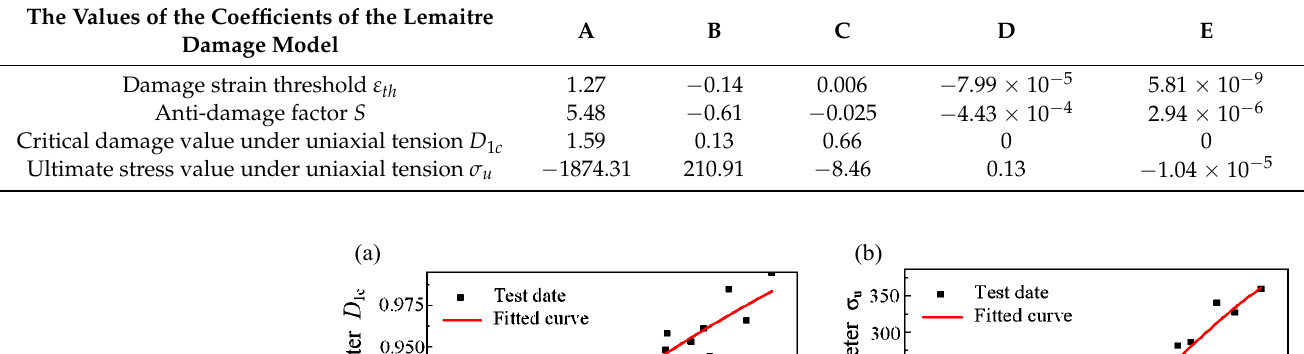
Table 5. Values of the coefficients of the modified Lemaitre damage model for Cr5 steel.